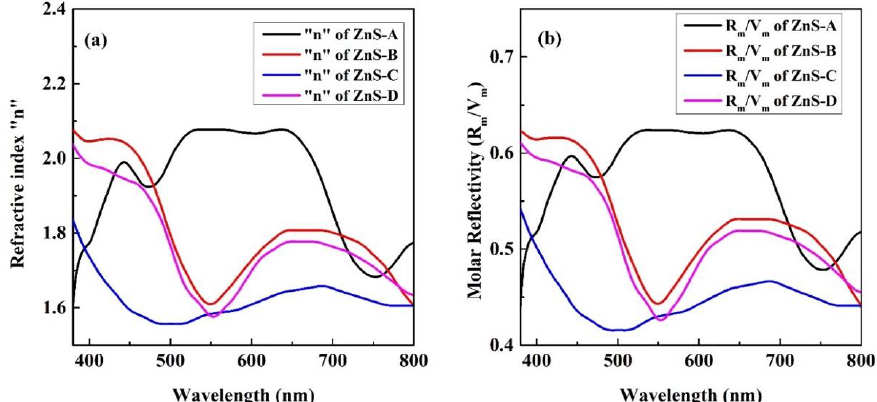
Figure 6. ( a ) Refractive indices and ( b ) molar reflectivity per unit volume are shown for ZnS deposited films against wavelength.